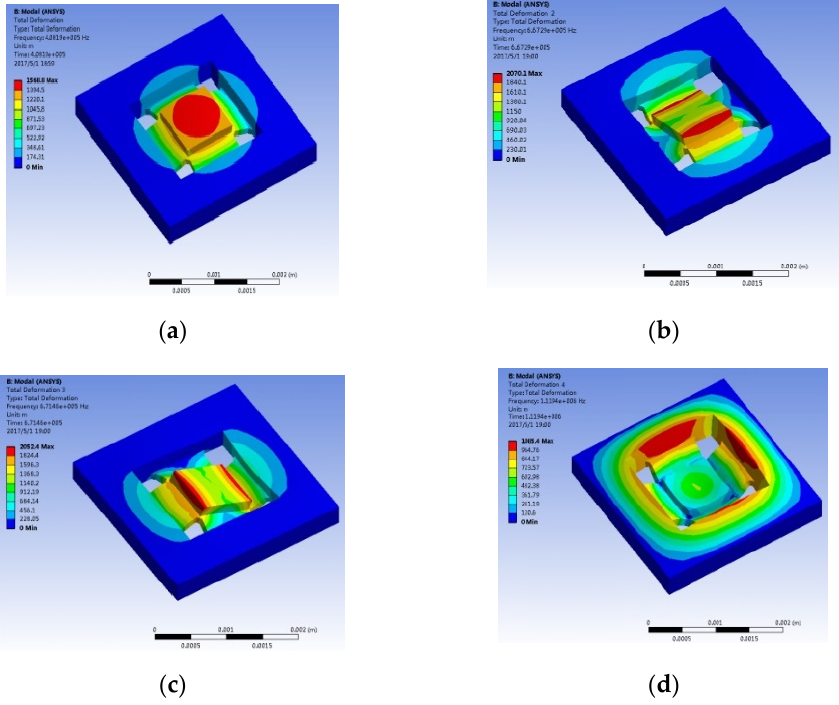
Figure 5. The lowest four modes of HGMA, ( a ) first mode shape, working mode; ( b ) second mode shape, disturbing mode; ( c ) third mode shape, disturbing mode; ( d ) fourth mode shape, disturbing mode.